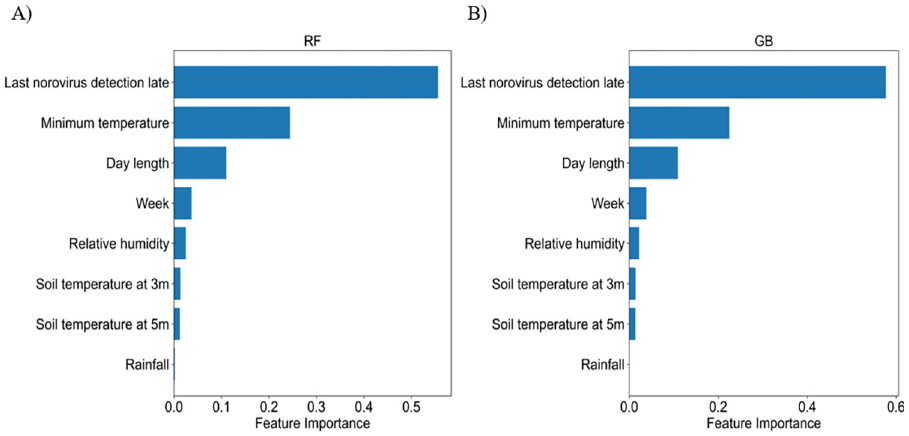
Fig 6. Feature importance of A ) RF and B )